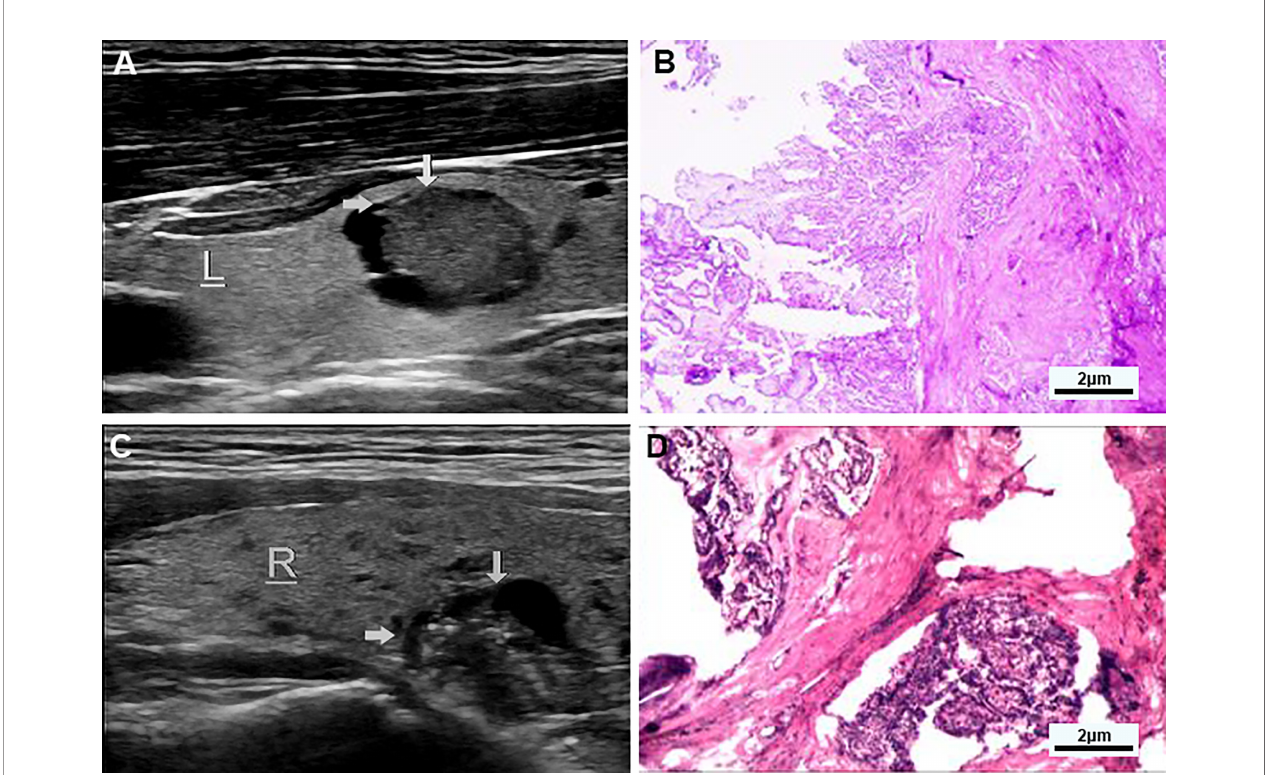
FIGURE 2 | (A, B) Examples of typical ultrasonographic and pathological sections of predominant solid partially cystic thyroid nodules. Longitudinal section of a cystic-solid nodule of the thyroid, mainly solid, with smooth and irregular margins, and an acute angle between the solid part of the anterior wall and the nodule wall (indicated by the gray arrow). It is hypoechoic, and the free edge is not smooth. TI-RADS grade 5 and the pathology con fi rmed papillary thyroid carcinoma, invading surrounding tissues. (C, D) Examples of typical ultrasonographic and pathological sections of macrocalci fi cation cystic thyroid nodules. Longitudinal section of a cystic-solid nodule of the thyroid gland, mainly cystic, with smooth and irregular borders, and an acute angle between the solid part attached to the posterior wall and the nodule wall (indicated by the gray arrow) has multiple strong echogenic light spots, which are isoechoic, and the free edge is not smooth, and the pathology con fi rmed papillary thyroid